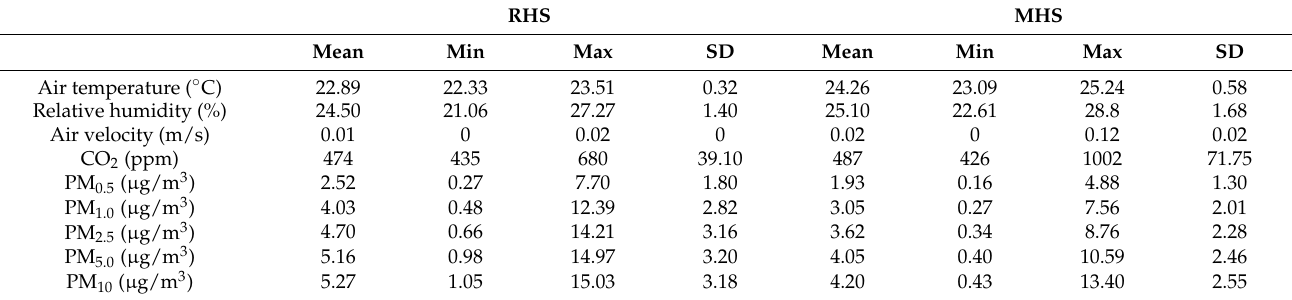
Table 3. Statistics of the measured data.